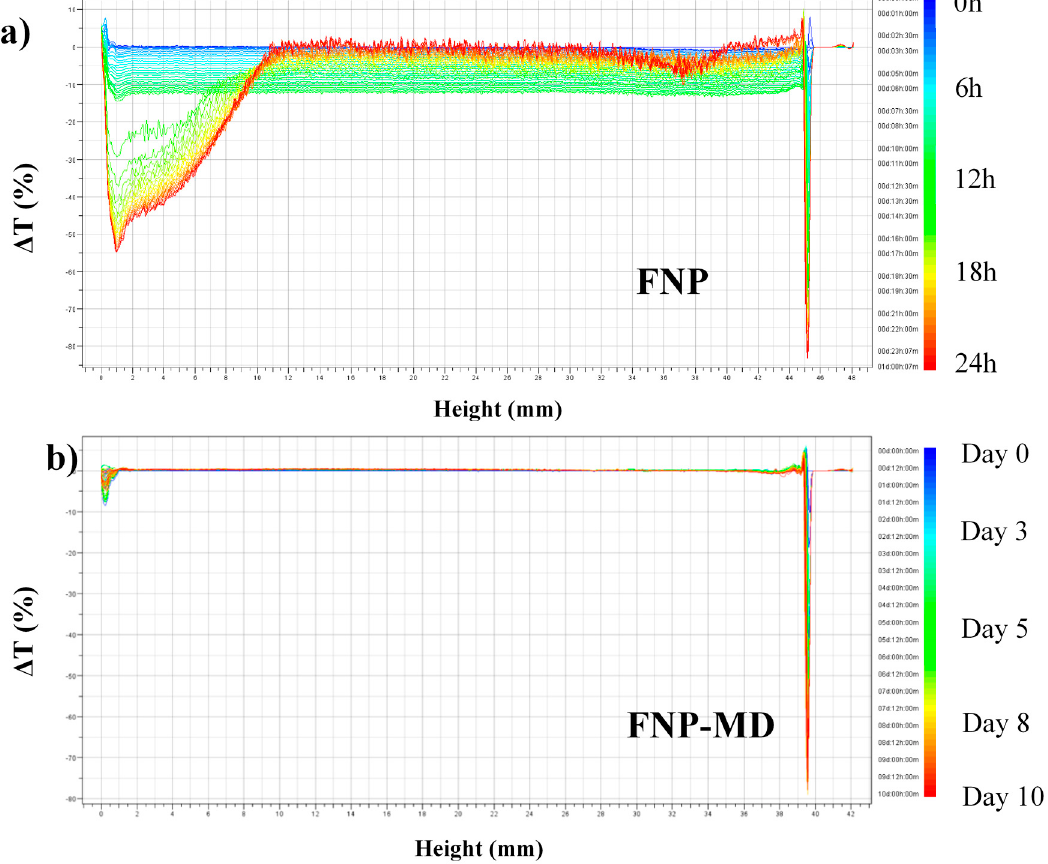
Figure 4. Delta transmission scanning results of nanofluid samples. ( a ): FNP (for one day); ( b ): FNP-MD (for 10 days).